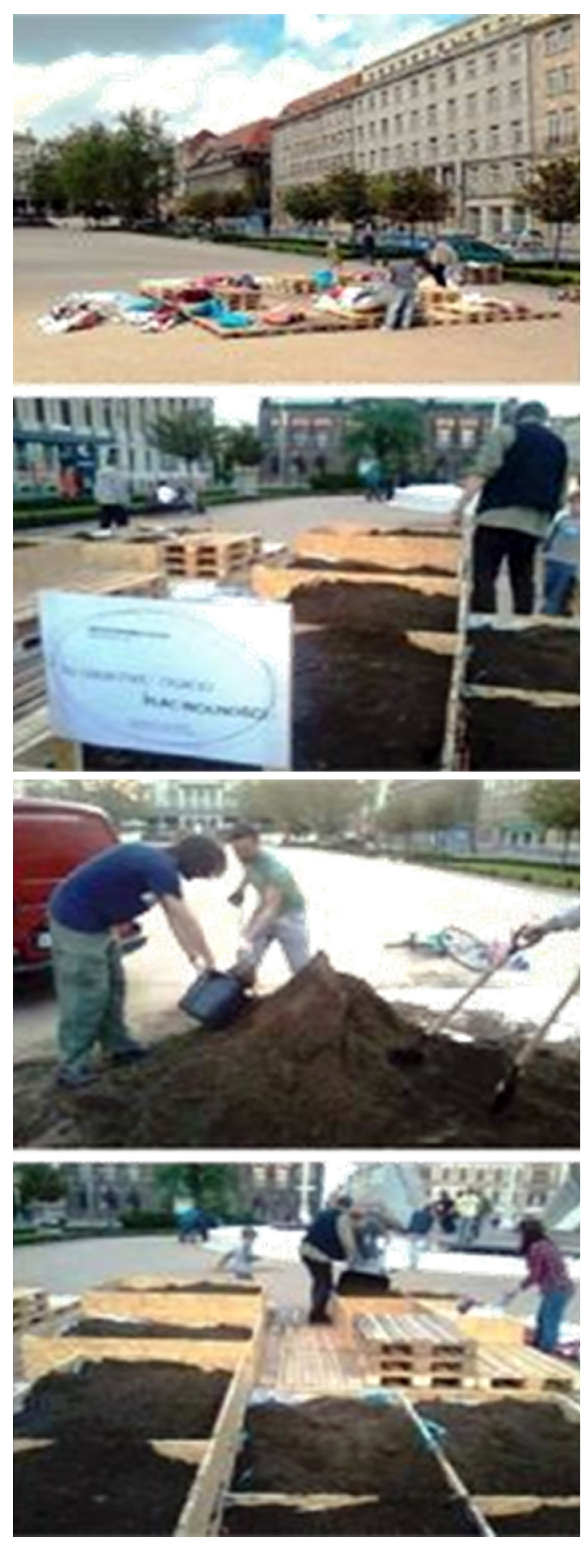
Picture 2. The beginnings of the community garden at Liberty Square in